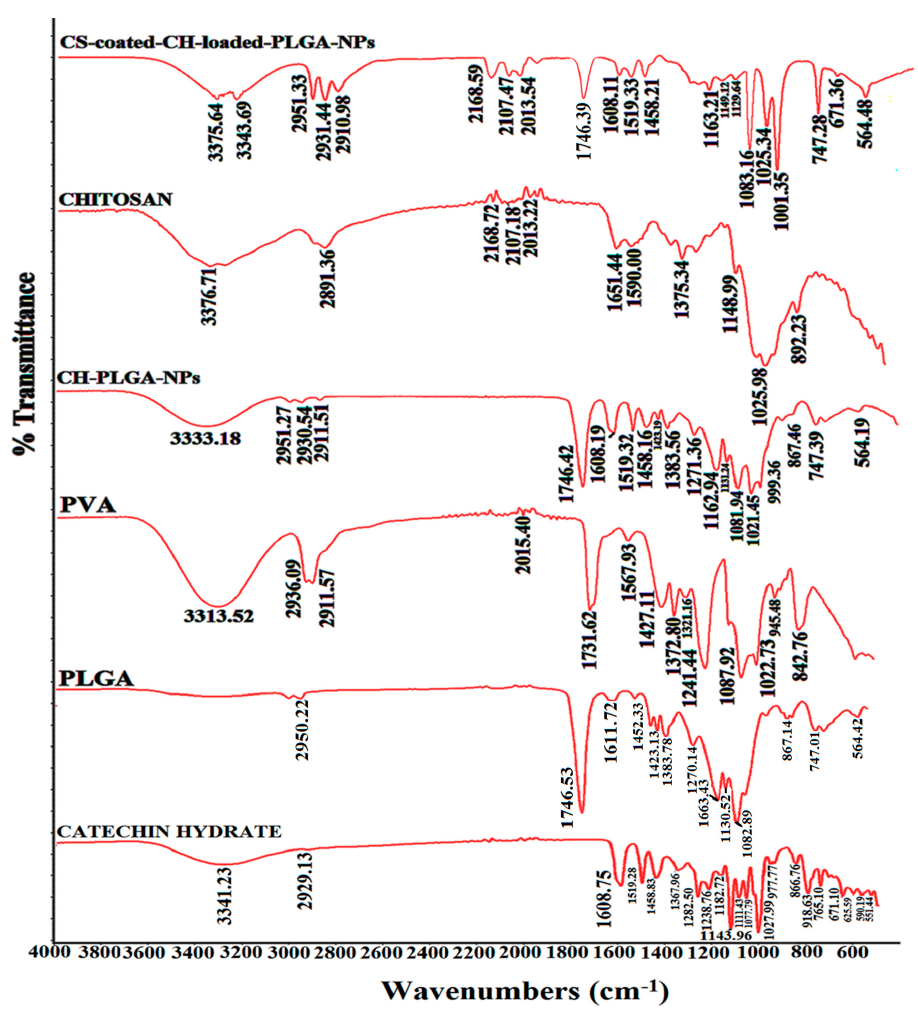
Figure 7. Different Fourier transform infrared spectroscopy (FTIR) spectra with an attenuated total